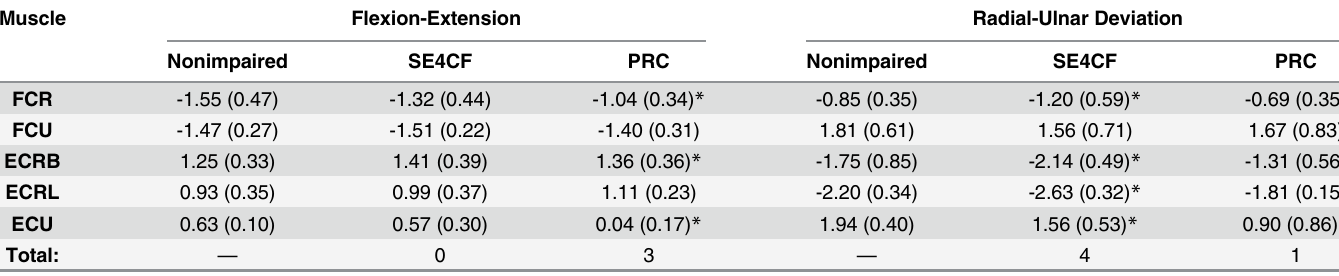
Table 2. Primary Wrist Muscles: Experimentally Measured Wrist Muscle Moment Arms #